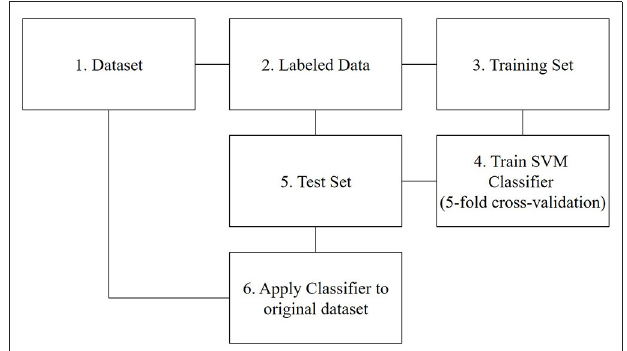
FIGURE 1 | The steps of data